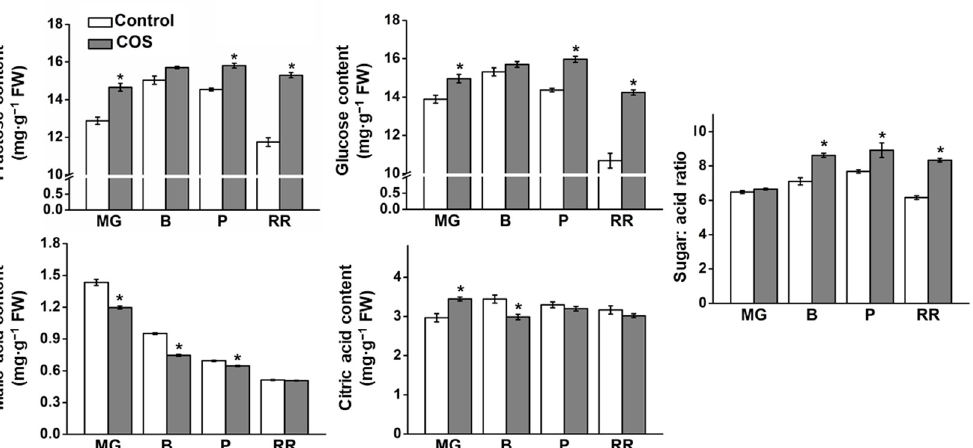
Figure 2. Effect of COS on the contents of sugars and organic acids, as well as the sugar/acid ratio, in tomato fruits. Data represent the means ± SD of three biological replicates. The asterisk represents a significant difference compared with the control based on Student’s t ‐ test (* p < 0.05). MG: mature green; B: breaker; P: pink; RR: red ripened. FW: fresh weight.